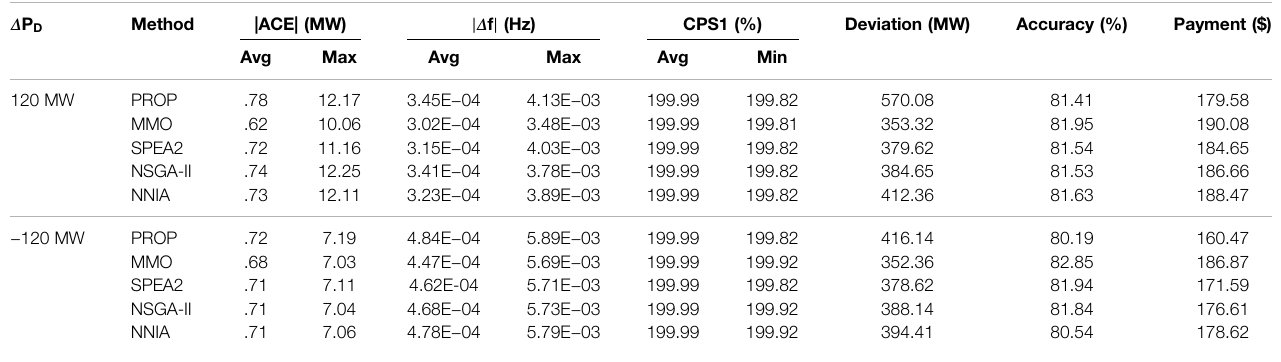
TABLE 5 | Result comparison of online optimization under different disturbances. Δ P